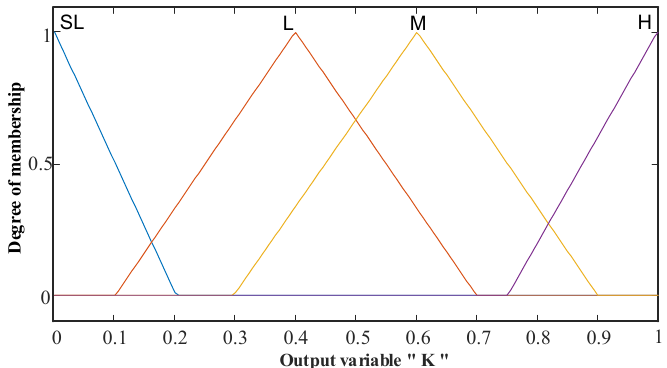
Figure 10. Regenerative braking ratio membership function.